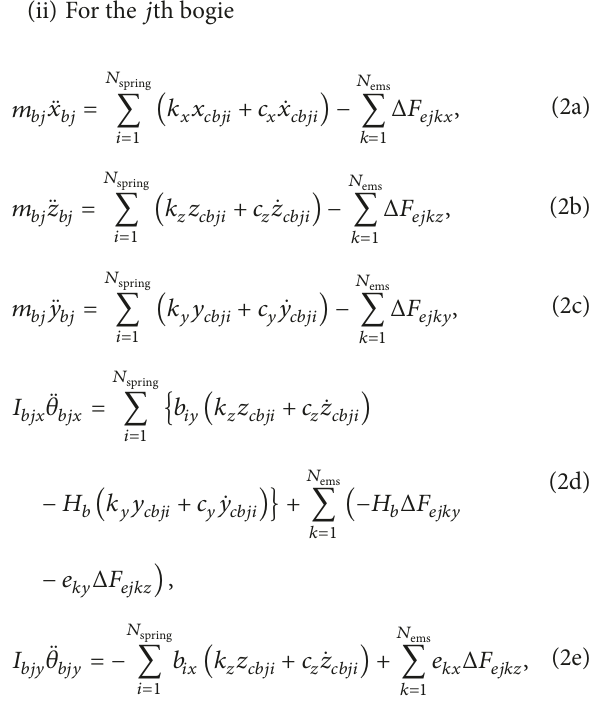
Figure 1: A 3D model of a cabin and four bogies in a maglev